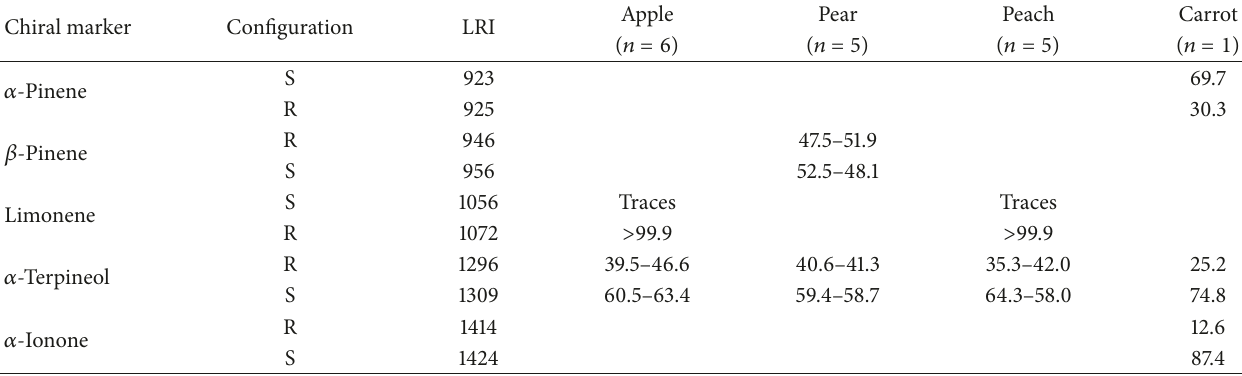
Table 3: Chiral markers, calculated LRI, and corresponding enantiomeric ratio for noncitrus fruit fibre. Chiral